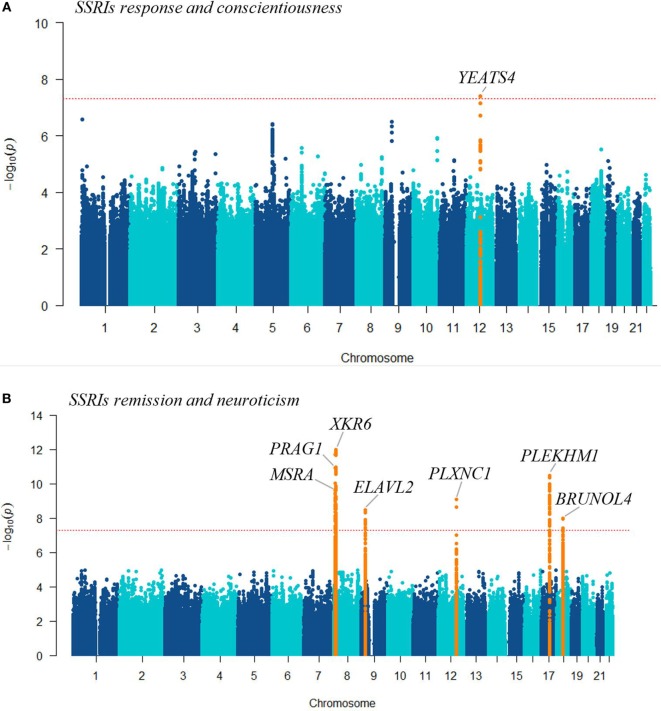
The Manhattan plots show the results of the cross-trait meta-analysis of genome-wide association studies (GWASs) on selective serotonin reuptake inhibitors treatment outcomes (response or remission) with GWASs on: (A) conscientiousness personality trait; (B) neuroticism personality, highlighting the loci that showed genome-wide significance (orange), and the nearest genes. The −log10 (cross-trait p-value) is plotted against the physical position of each SNP on each chromosome. The threshold for genome-wide significance (cross-trait p-value <5 × 10−8) is indicated by the red dotted horizontal line.